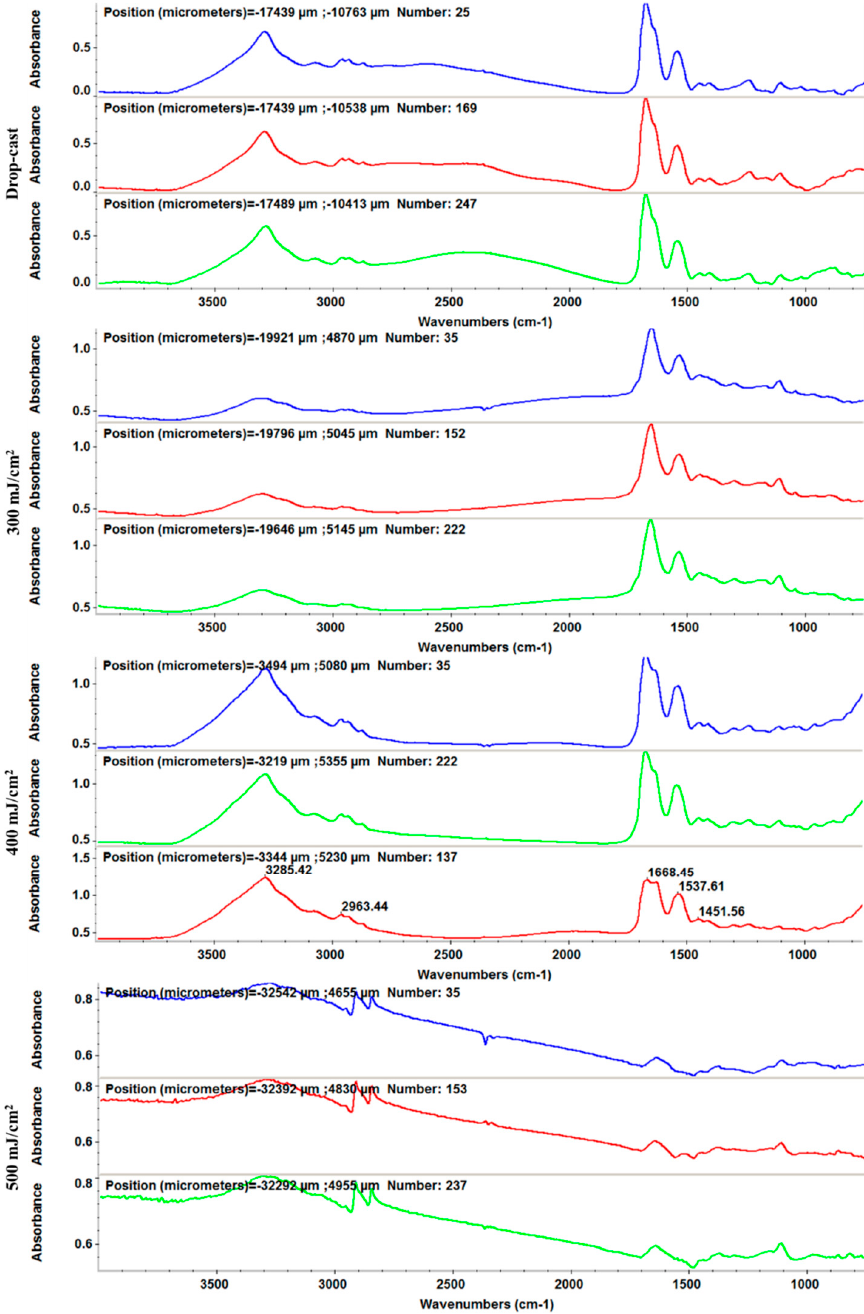
Figure 7. IR spectra of Fe 3 O 4 @CS/LyZ drop-cast and coatings obtained at differences laser fluence. Analyzing the integrity of IR spectra for each sample deposited at different laser flu- ences and the corresponding drop-cast coating, we selected the 400 mJ/cm 2 laser fluence value as the best compromise between the deposition rate and the stoichiometric transfer to deposit the composite coatings for biological assays.